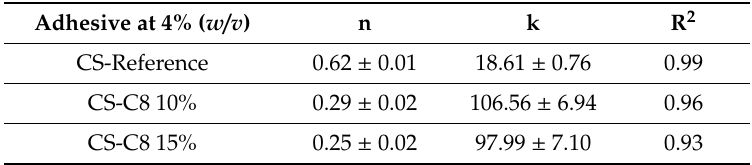
Table 3. Rheological characteristics of chitosan and alkyl-chitosans at 4% ( w / v ) using the Ostwald-de-Waele relationship. (“n” represents flow index and “k” represents the consistency